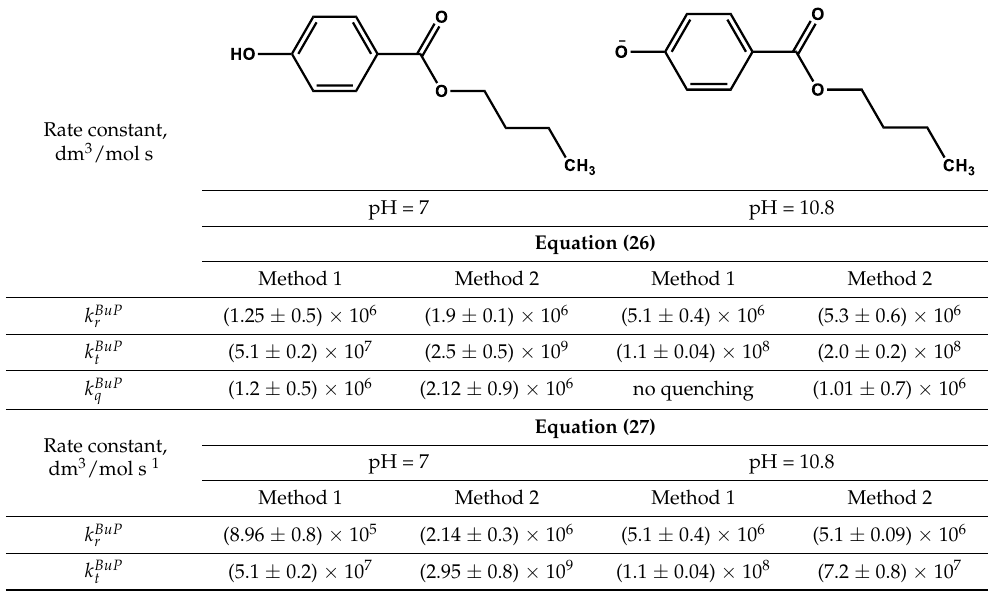
Rate constant, dm 3 /mol s